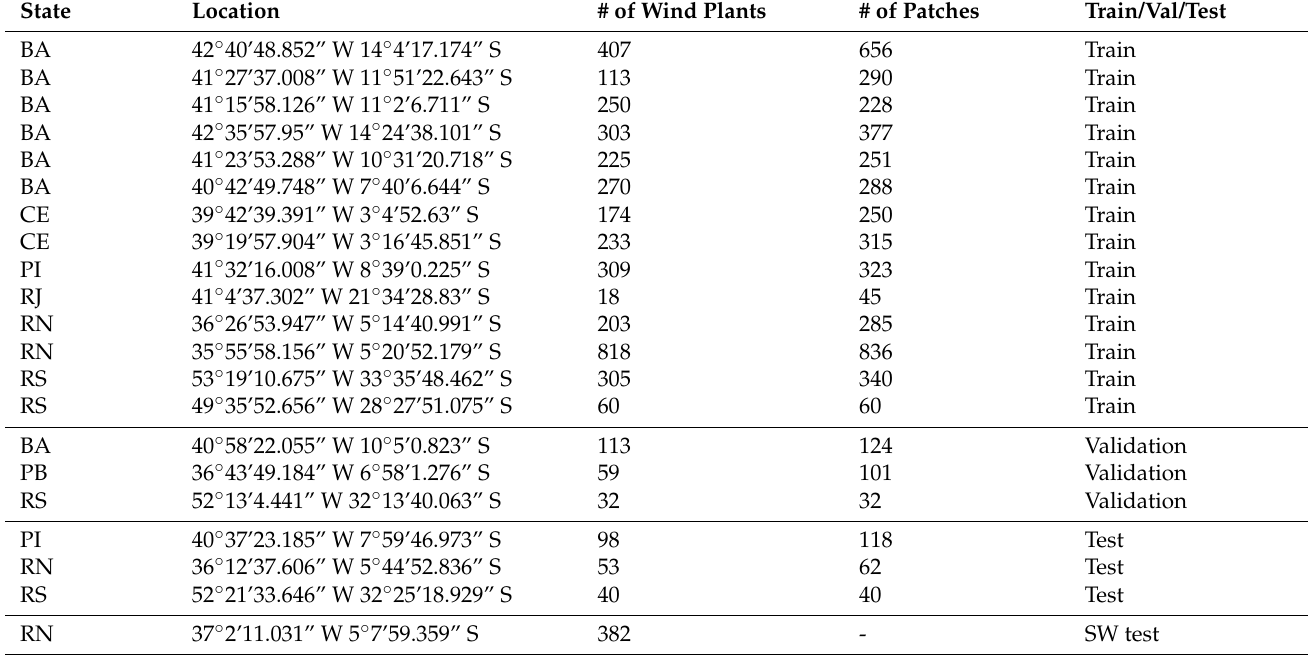
Table 1. Dataset information considering the state, location (latitude and longitude), number of wind plants, number of patches, and the set (train, validation, test, or sliding windows (SW)). The dataset considered the following Brazilian states: Bahia (BA), Cear á (CE), Piau í (PI), Rio Grande do Norte (RN), Rio Grande do Sul (RS), and Rio de Janeiro